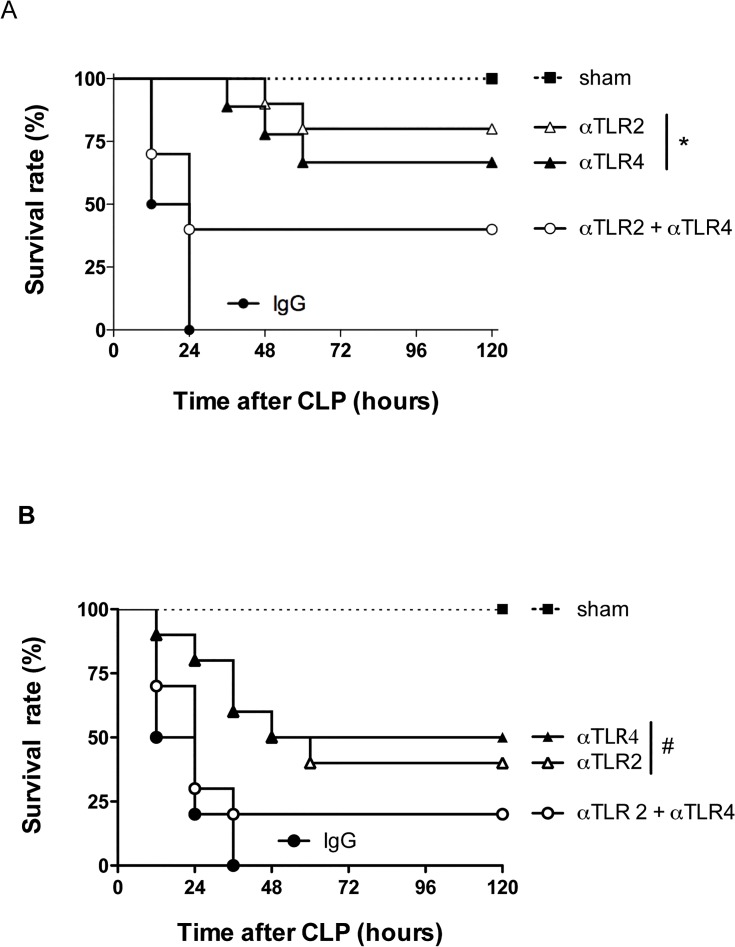
Blockade of either TLR2 or TLR4 improves survival during polymicrobial sepsis.The survival rate was analyzed following CLP procedure comparing the effect of the treatment with isolated or combined anti-TLR2 and anti-TLR4 antibodies. The treatments were performed 45 minutes before (A) or 3 hours after (B) the CLP procedure. The combined treatment with both anti-TLR2 and anti-TLR4 showed a similar survival curve compared to the negative control isotype IgG treated-group (CLP) * P<0.001 between Individual antibody treatments and negative control (IgG). # p<0.05 between individual antibody treatments and negative control (IgG) Antibody dose (1 mg/animal). (n = 10/group).